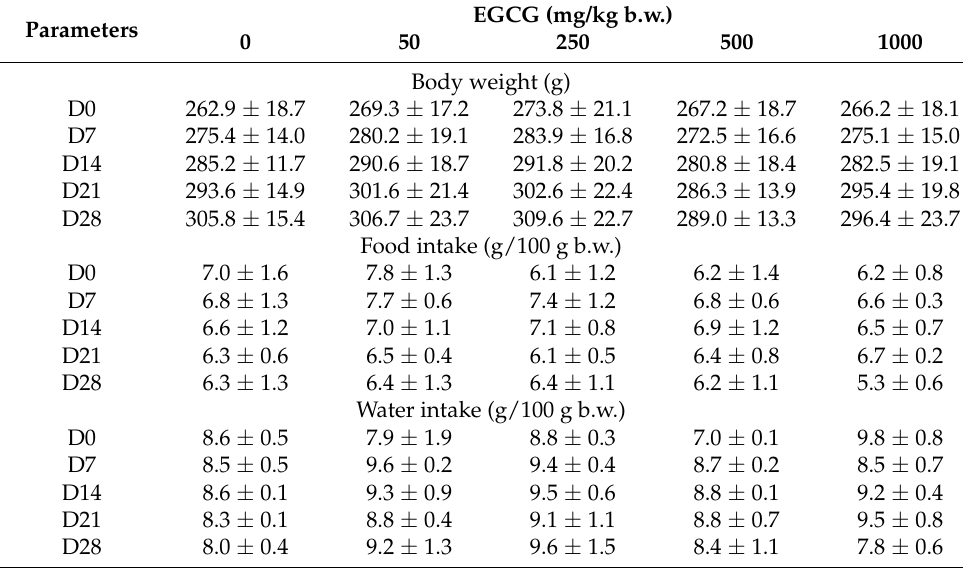
Table 3. Body weight, food and water intakes.